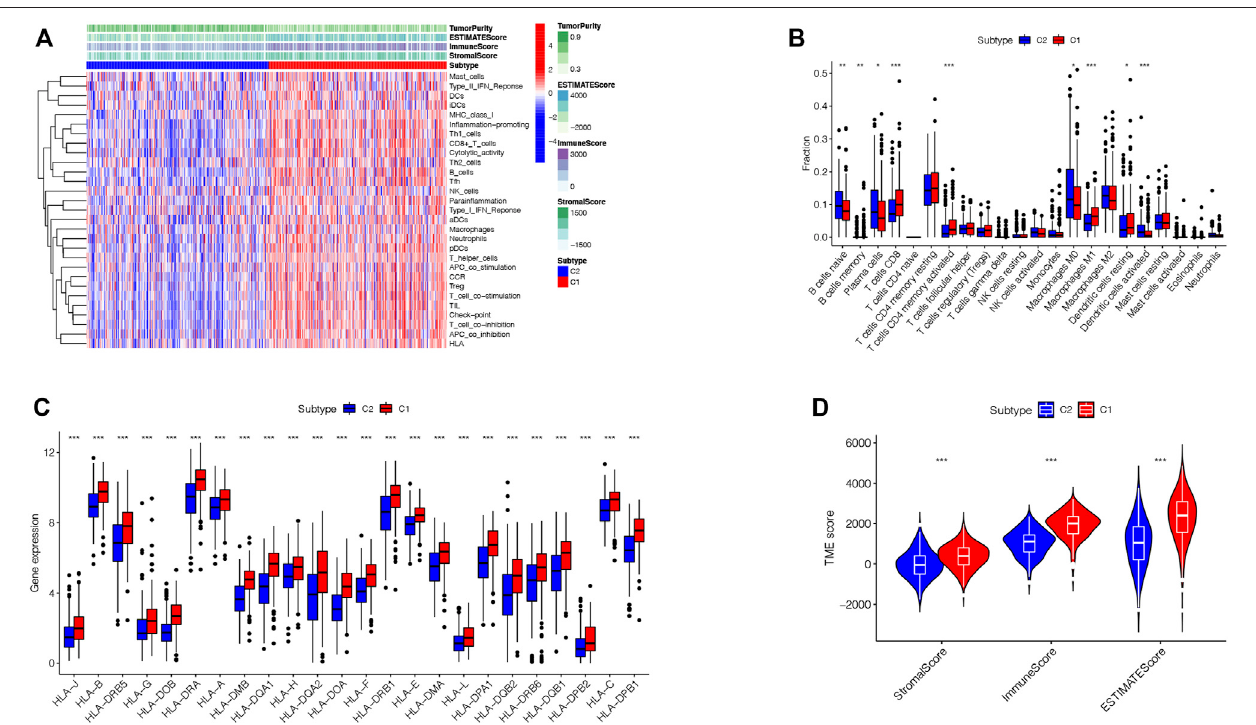
FIGURE 3 | TME in fi ltration in two subtypes. (A). Immunological characteristics of the two subtypes. (B) . Correlations of the immune cell in fi ltration level between two subtypes. (C) . Correlations of HLA gene expression level between two subtypes (* p < 0.05, ** p < 0.01, *** p < 0.001). (D) . Correlations of Stromal-score, Immune- score, ESTIMATE-Score, and TME score between two